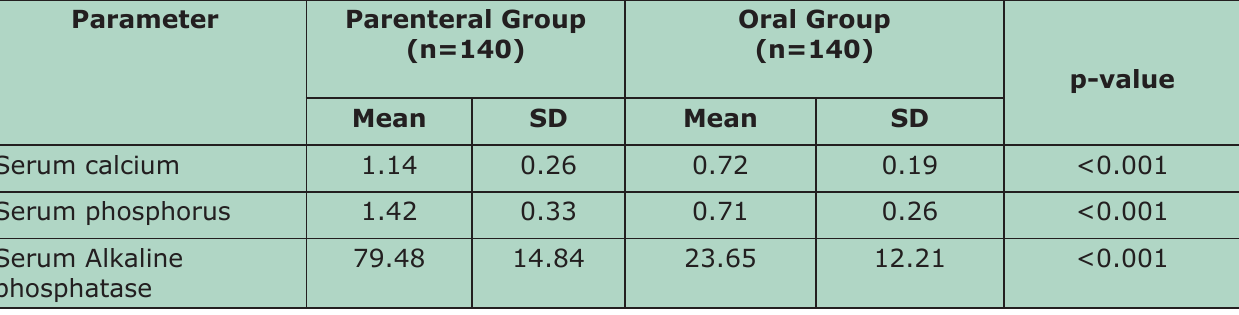
Table-IV: Comparison of parental and oral vitamin D supplementation in the treatment of nutritional rickets regarding the mean change (n=280).